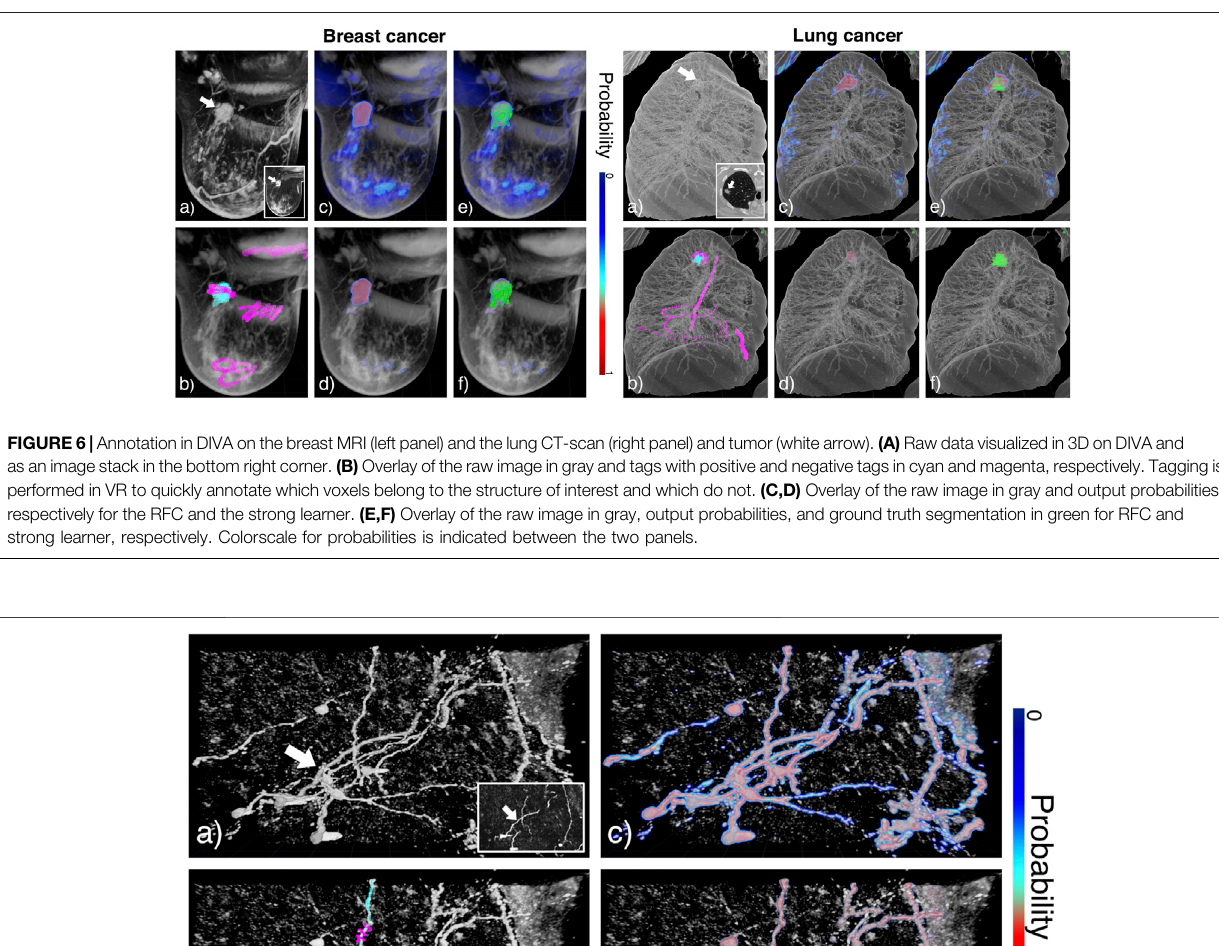
Frontiers in Bioinformatics |